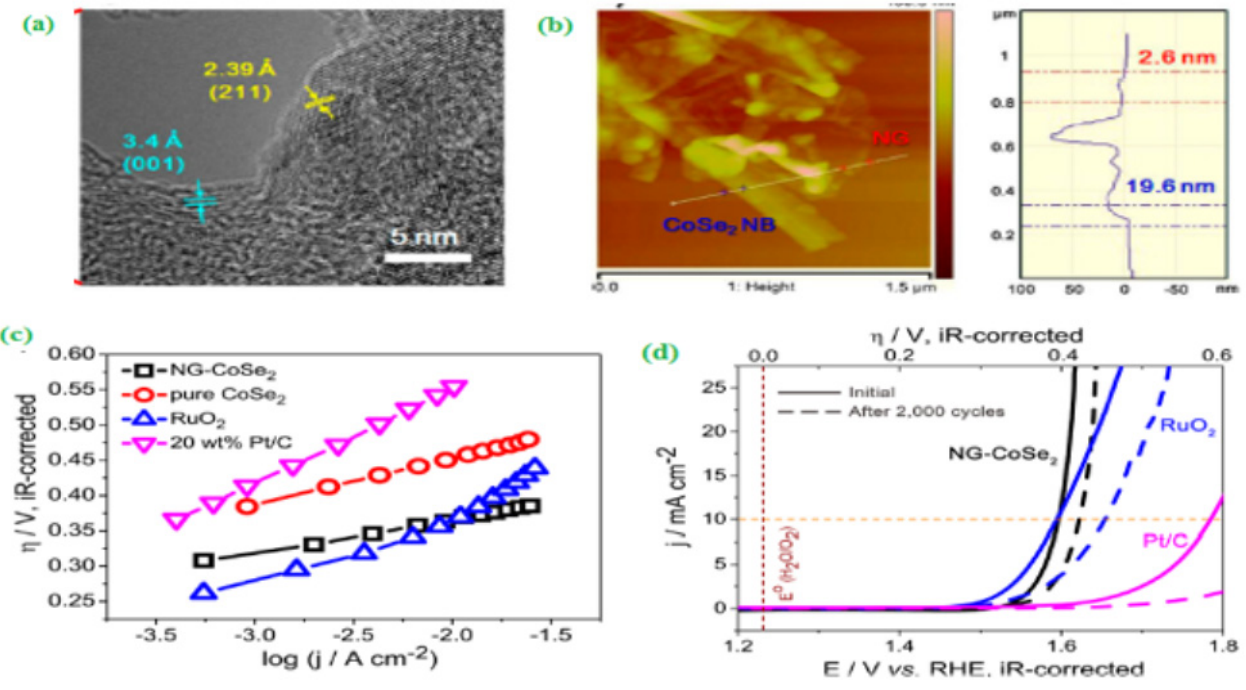
Figure 12. ( a ) HR–TEM image of CoSe 2 nanobelt, ( b ) AFM image and corresponding height profile of NG-CoSe 2 composite, ( c ) Tafel plot, and ( d ) OER polarization curves of NGCoSe 2 composite, RuO 2 , and 20 wt % Pt/C catalysts before and after potential sweeps (0.3–0.8 V vs. Ag/AgCl) for 2000 cycles. Copyright 2014 by American Chemical Society [98].